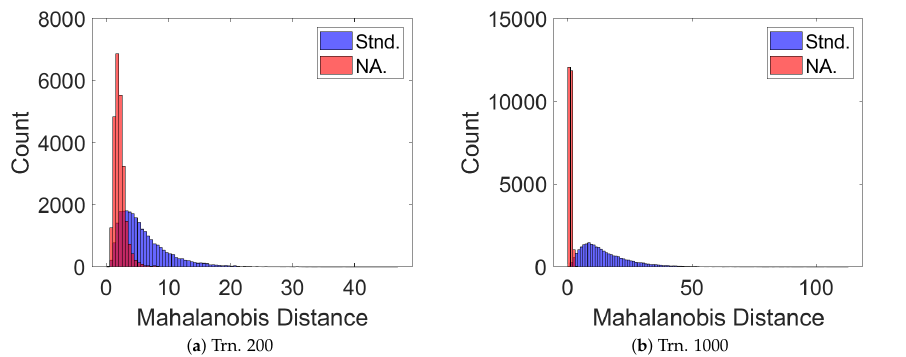
Figure 11. The Mahalanobis distance from the true state to the GPR-predicted mean given the GPR- predicted covariance for Case G at training samples of ( a ) 200 and ( b ) 1000 given uncertain RA and DEC measurements for the standard MV-GPR (blue) and the noise-aware MV-GPR